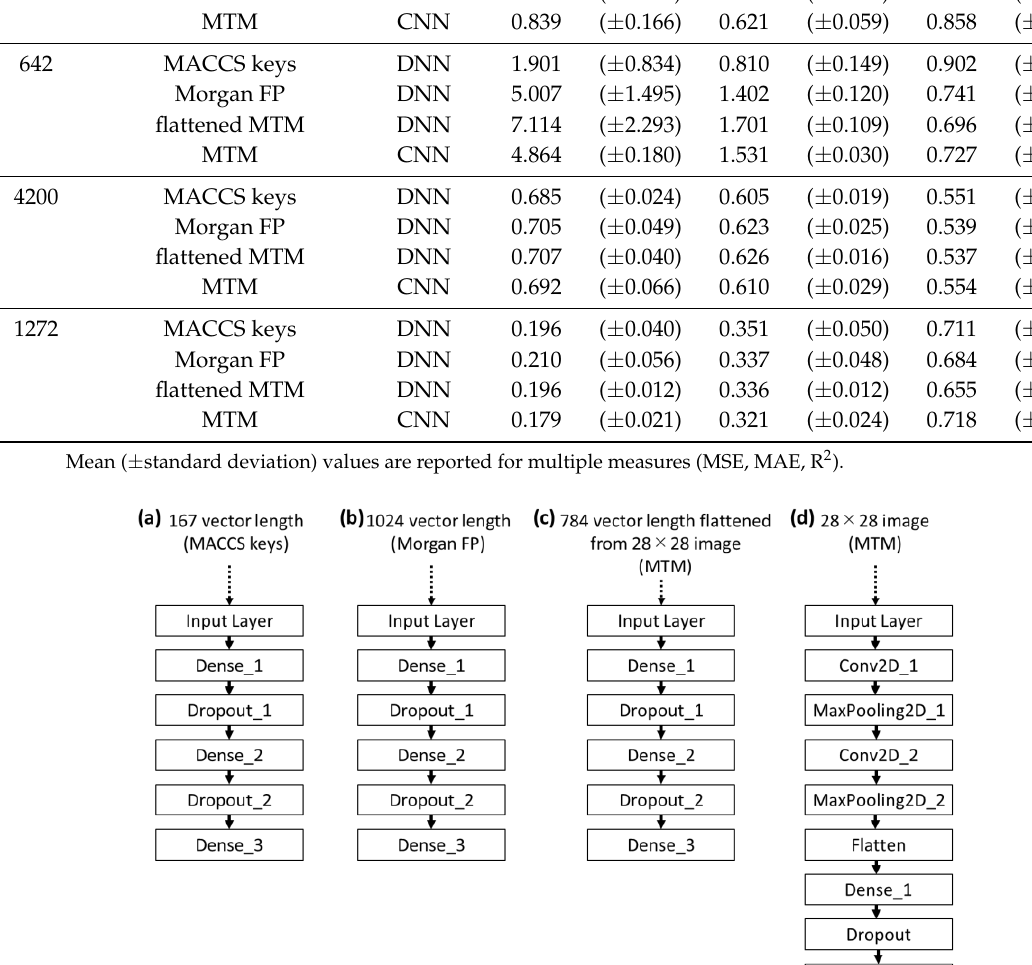
Table 2. Performance comparison of the four datasets for four models.